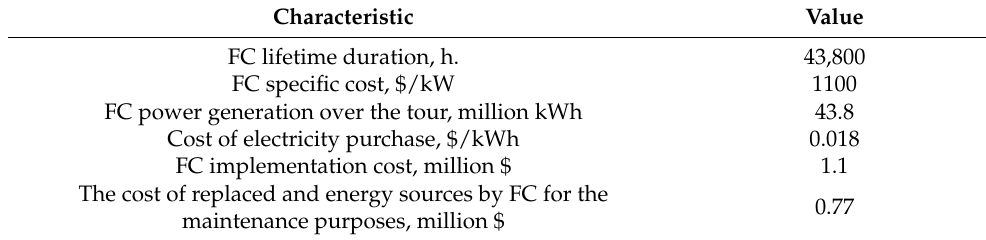
Table 3. Characteristics of the fuel cell functioning for the purpose of maintenance of the plant. Characteristic Value FC lifetime duration, h. 43,800 FC specific cost, $/kW 1100 FC power generation over the tour, million kWh 43.8 Cost of electricity purchase, $/kWh 0.018 FC implementation cost, million $ 1.1 The cost of replaced and energy sources by FC for the maintenance purposes, million $